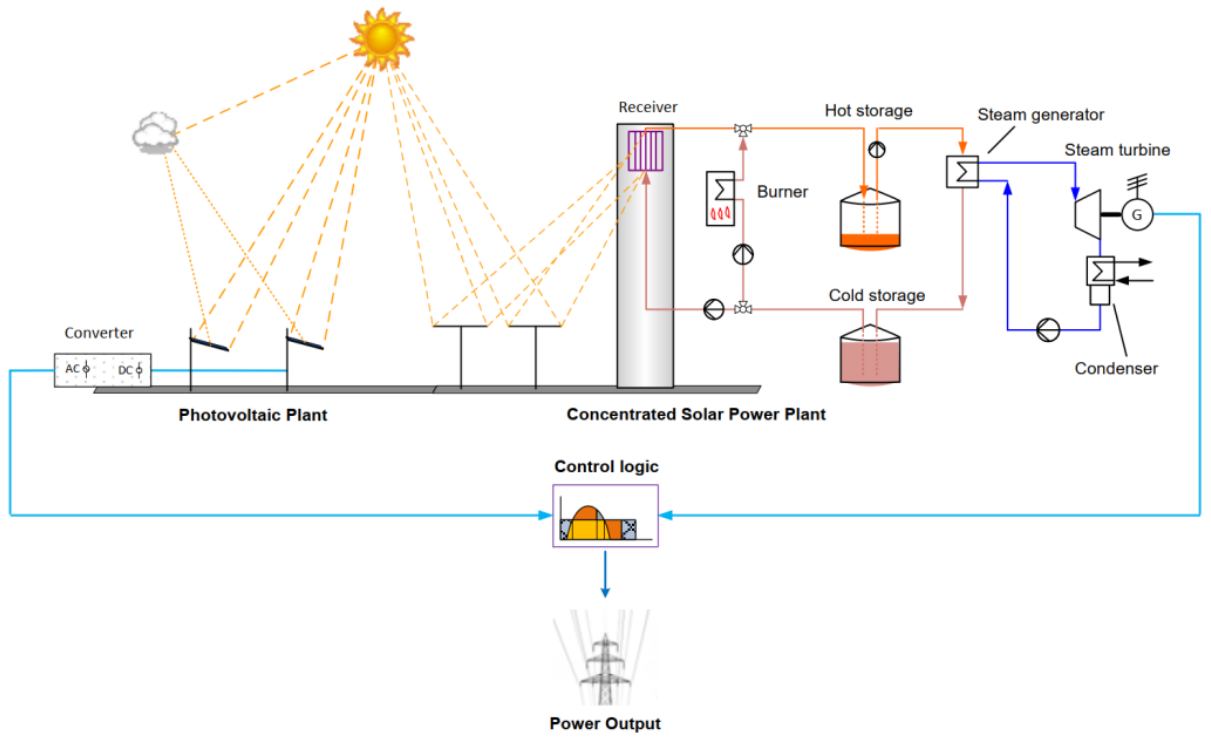
Figure 5. Sketch of a CSP + PV + gas burner hybrid plant (CP3 case).